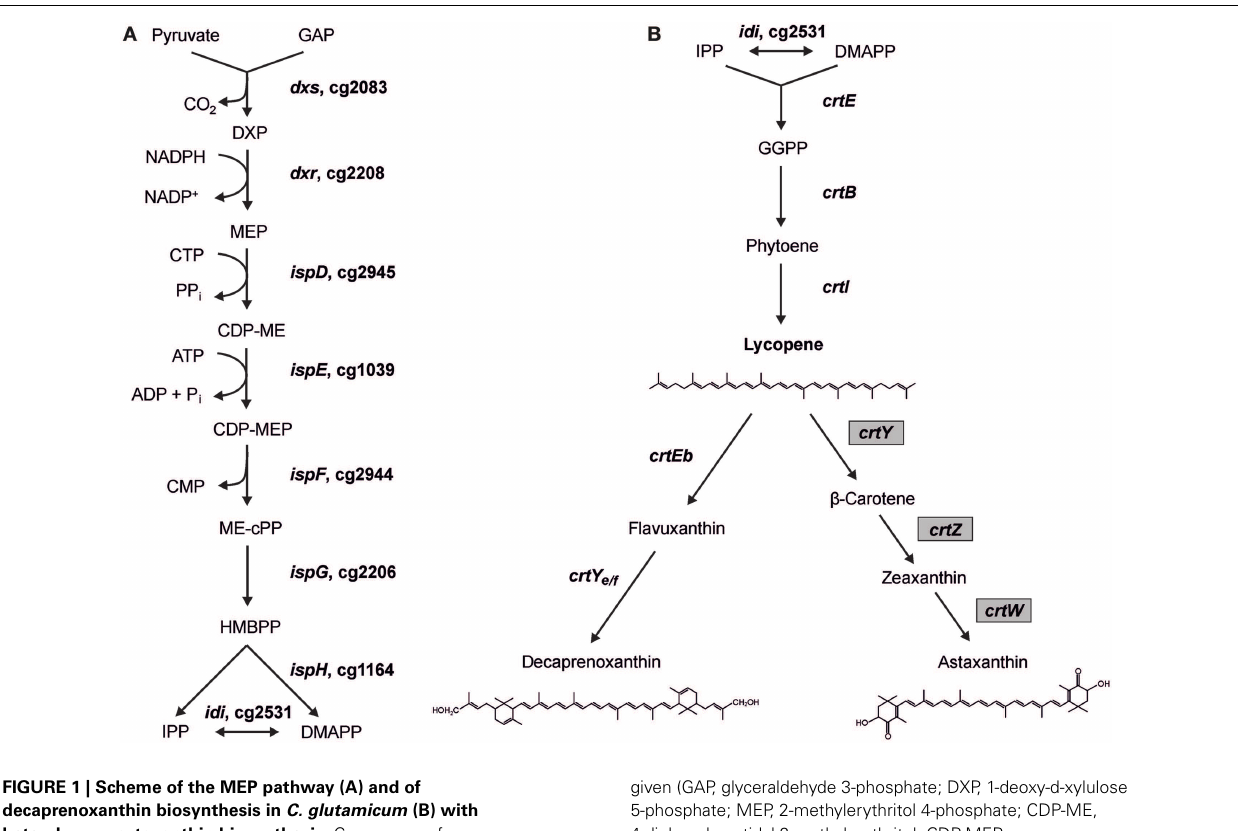
given (GAP, glyceraldehyde 3-phosphate; DXP, 1-deoxy-d-xylulose 5-phosphate; MEP, 2-methylerythritol 4-phosphate; CDP-ME, 4-diphosphocytidyl-2-methylerythritol; CDP-MEP, 4-diphosphocytidyl-2-methylerythritol 2-phosphate; ME-cPP, 2-methylerythritol 2,4-cyclopyrophosphate; HMBPP, 4-hydroxy-3-methyl-but-2-enyl pyrophosphate; IPP, isopentenyl pyrophosphate; DMAPP, dimethylallyl